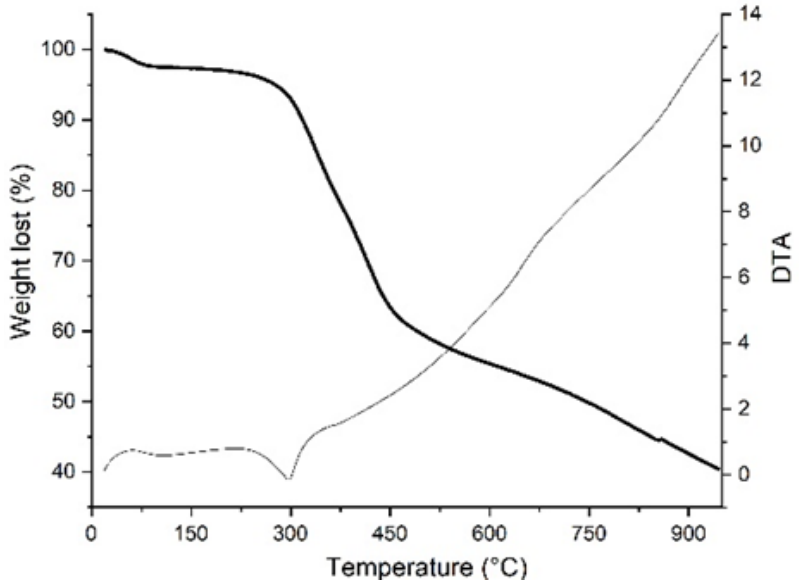
Figure 7. TGA and DTA analysis of PAN-PMMA electrospun membrane.